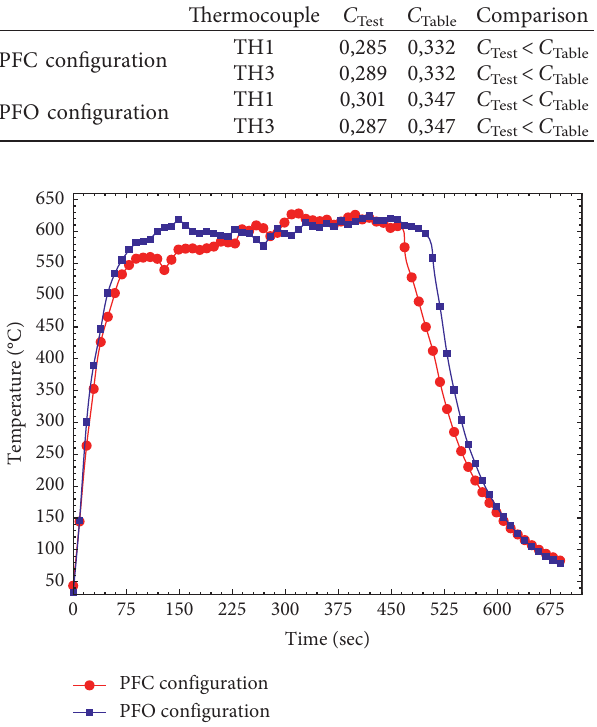
Figure 11: Confrontation between curves of flame temperature of PFO and PFC configurations.